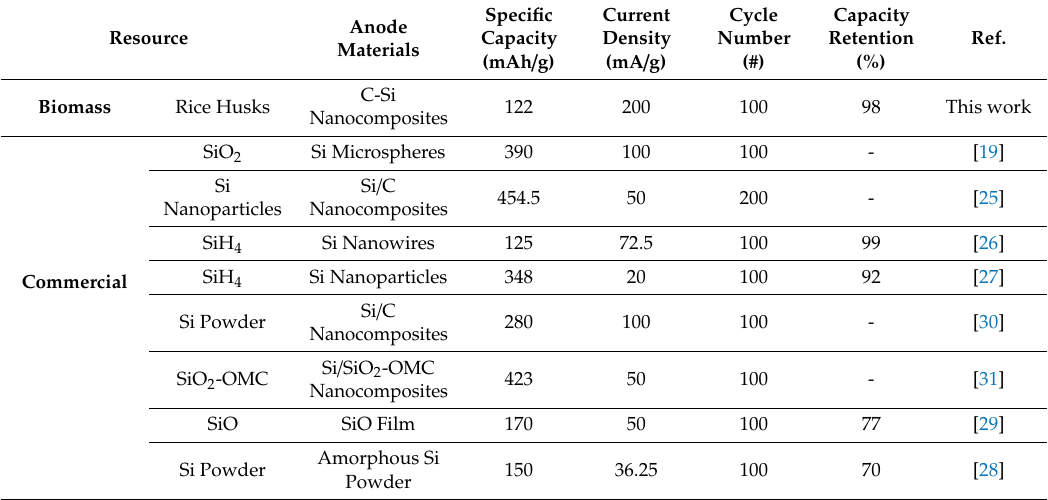
Table 1. Comparison of the electrochemical SIB anode performances for various Si-based nanocomposites. Resource